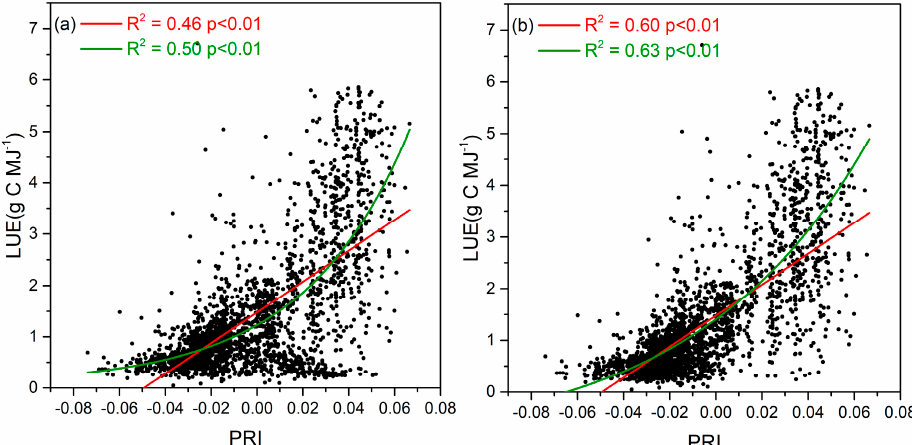
Figure 4. Comparison of the relationship between the LUE and the PRI not corrected by a BRDF model ( a ) and that between the LUE and the PRI corrected by a BRDF model ( b ) in the LUE and PRI data were measured every half-hour from April 2014 to March 2015. The red lines represent the linearly fitted functions, and the green lines represent the exponentially fitted functions.